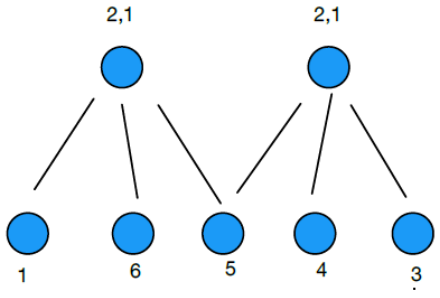
Figure 1. Buyer–seller